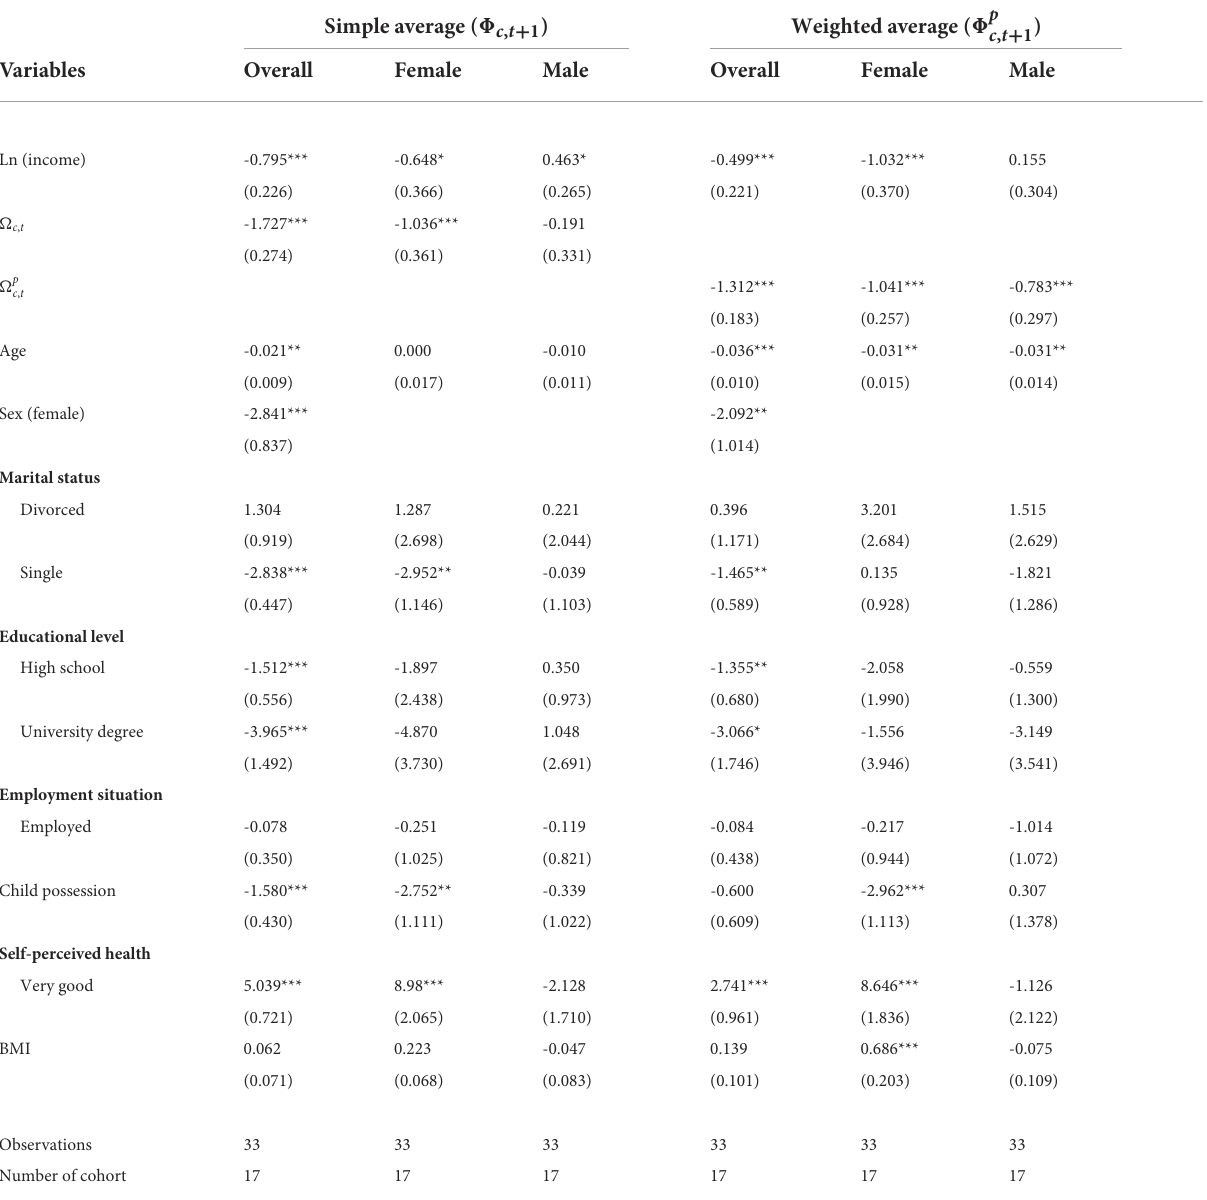
TABLE 4 Pseudo panel